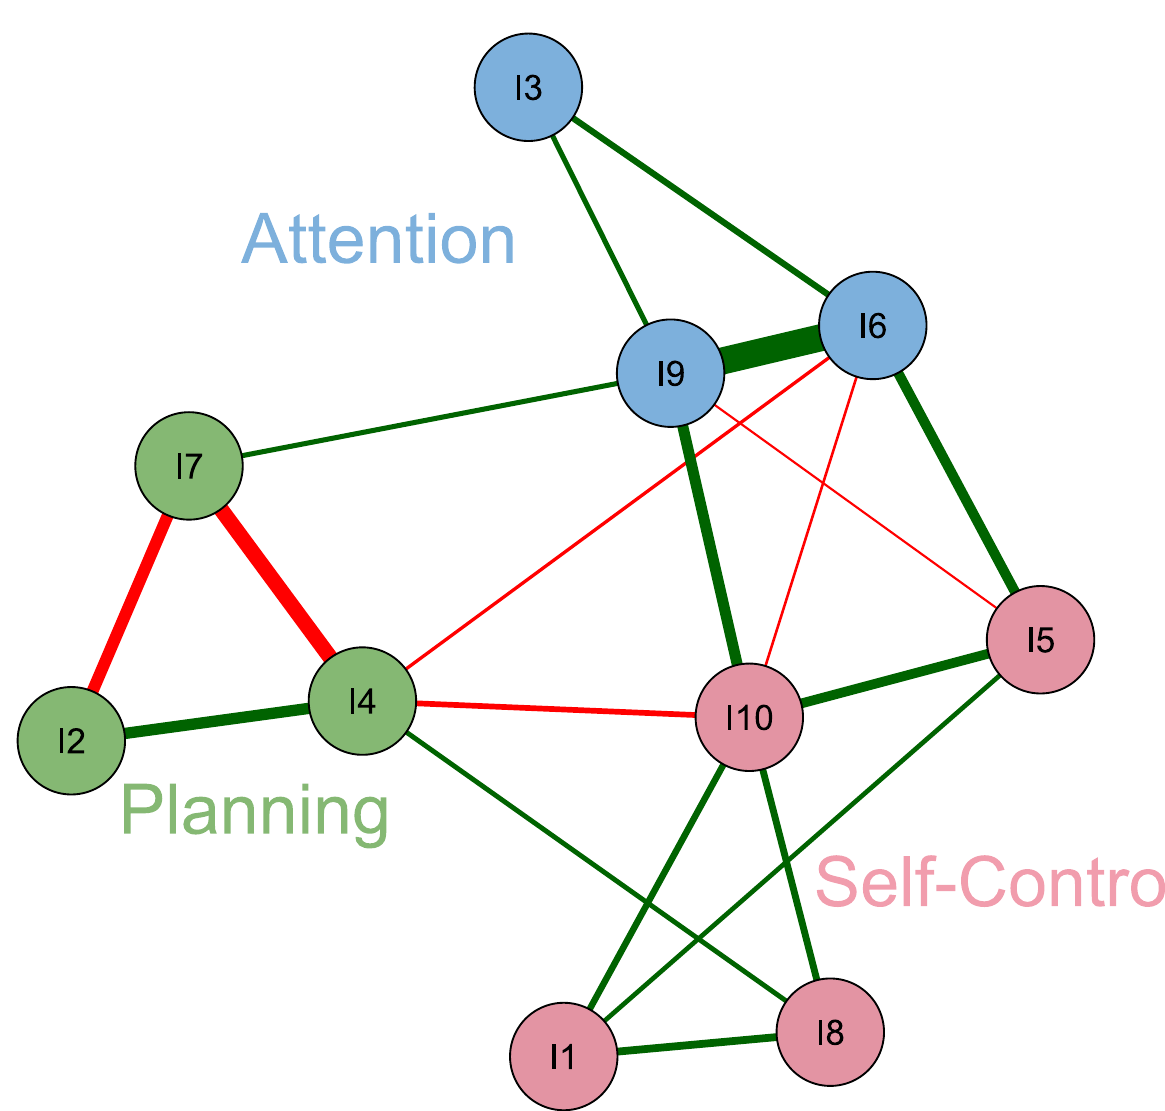
Fig 2. Network of partial correlations estimated during exploratory graph analysis showing three latent